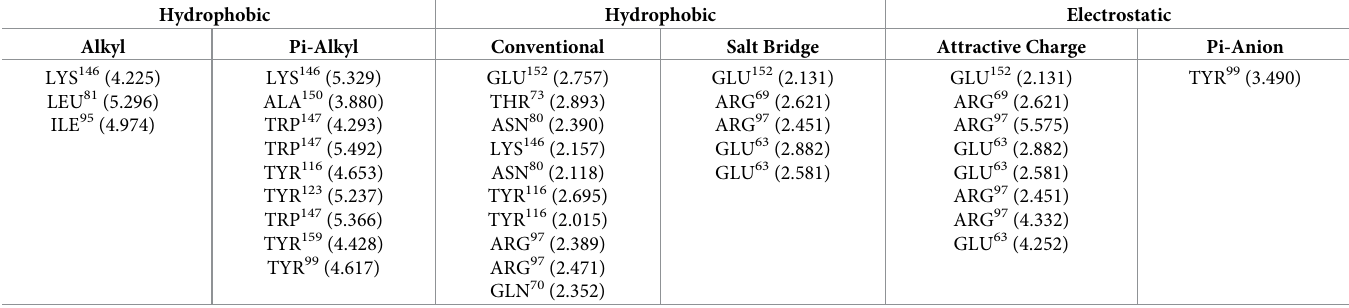
Table 8. Nonbonding interactions with their distances ( Å ) between epitope (RTFAMSSER) and HLA (HLA-C � 03:03).